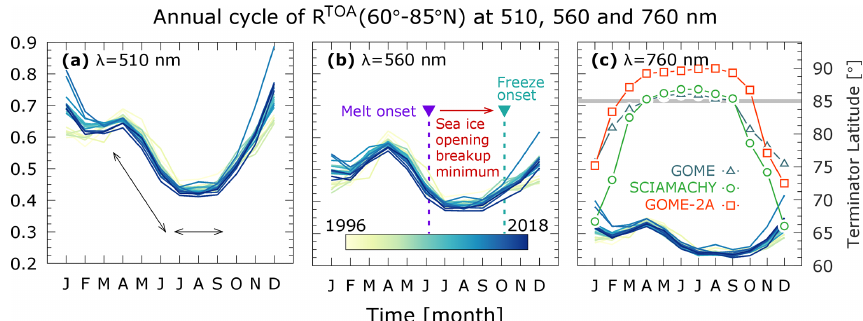
Figure 2. Annual cycle of spectral R TOA at three wavelengths ( λ = 510, 560, 760nm) for the full record from 1996 to 2018. All sets exhibit the demarcation between months of steep (April–May–June) and flat (July–August–September) gradient of R TOA . This shift leads by 1 month melt onset (6 June), followed by sea ice opening, breakup, minimum (16 July–September inclusive), and freeze onset (4 October) as observed with satellite brightness temperatures (Smith et al., 2020). In the rightmost panel is the terminator location of the three sensors with the 85 ◦ N (grey line) common threshold used for monthly R TOA